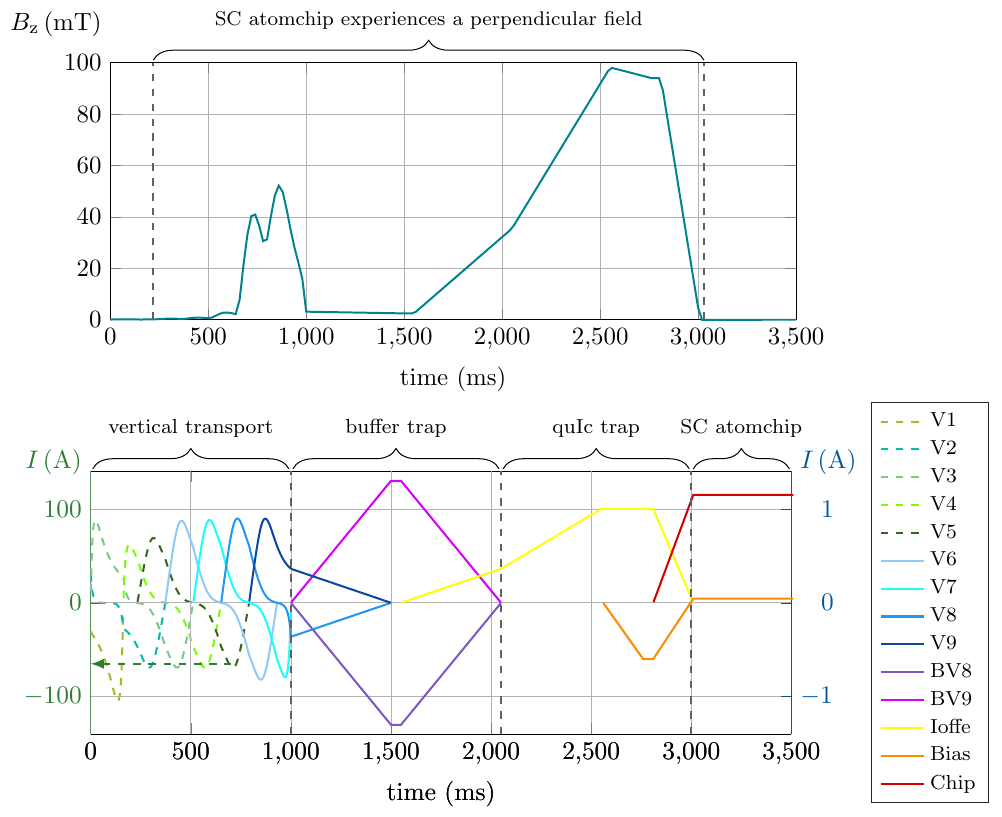
Figure 3: Magnetic field history (Top), perpendicular to the film experienced by the atomchip at the middle of the Z structure. The fields are calculated from the current sequence of the experiment (Bottom). Only the last sequence of the magnetic trans- port is shown which is the vertical section of the transport. The vertical section is split into the normal- (dashed lines) and super-conducting (solid lines) coils. The normal conducting coils go up to 100 A (left axis) whereas the superconducting coils / wire only go up to 2 A (right axis). This is proceeded by loading into a buffer quadrupole trap and subsequently into a quadrupole-Ioffe trap (quIc trap). The final seqeunce is the loading into the superconducting atomchip where a bias field and the transport current for the niobium wire is ramped up to a desired value that creates the trap. Details of the magnetic transport and loading schemes are discussed in detail in [ 37 ]